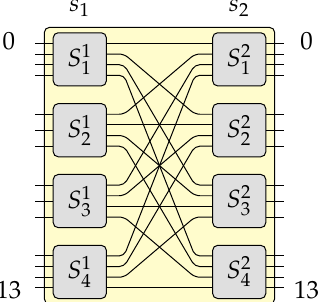
Figure 5. The MBA ( 14,4, g ) switching fabric for g = 2, g = 3, and g =